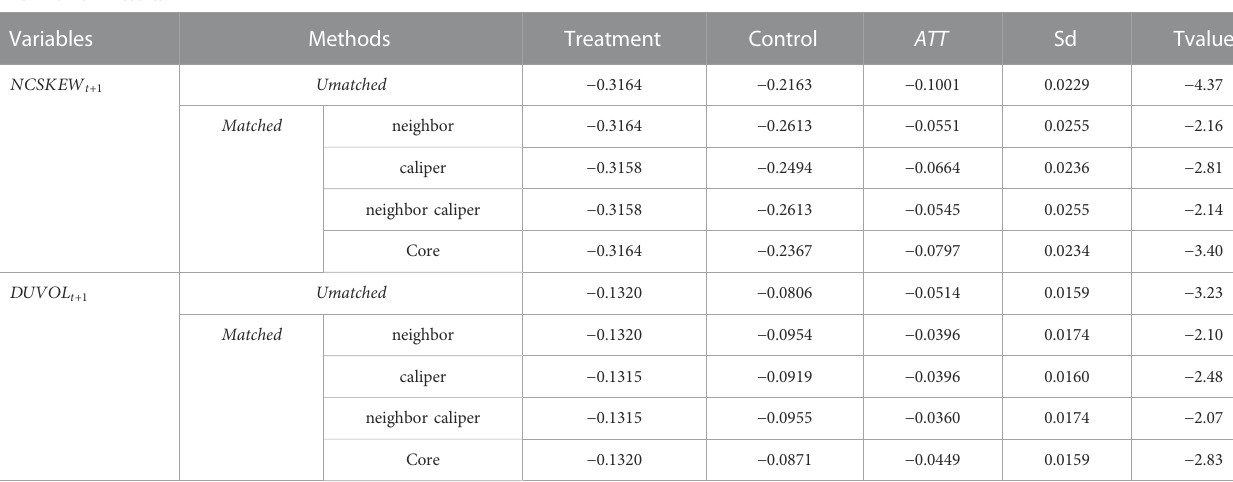
TABLE 6 PSM Results.